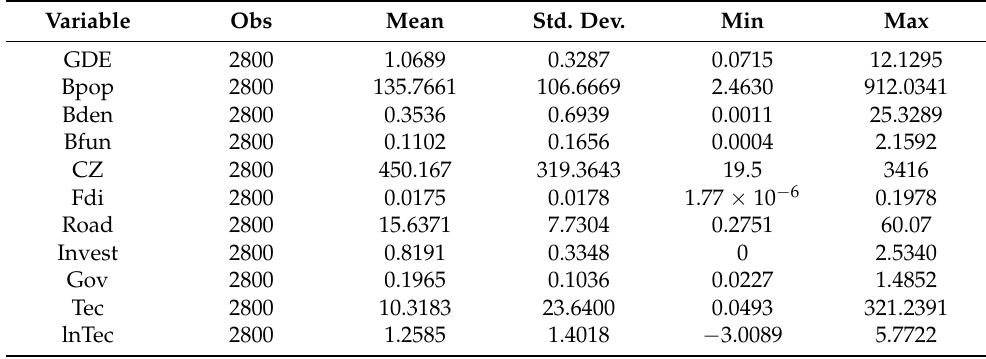
Table 3. Descriptive statistics of